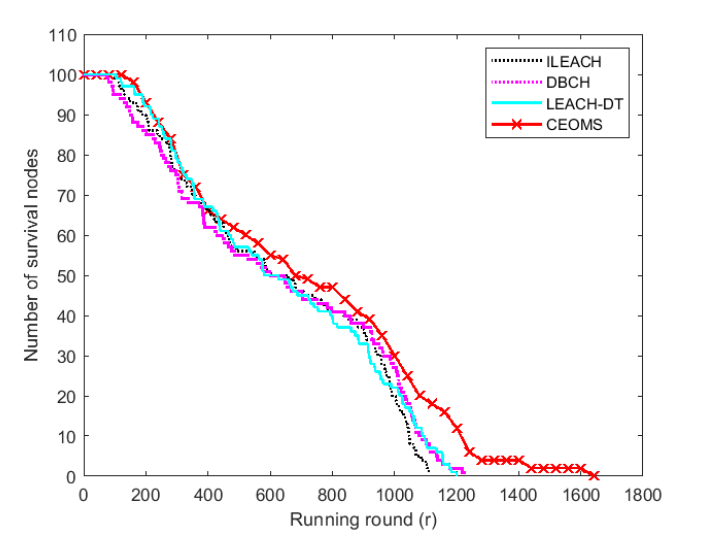
Figure 11. The number of surviving nodes.